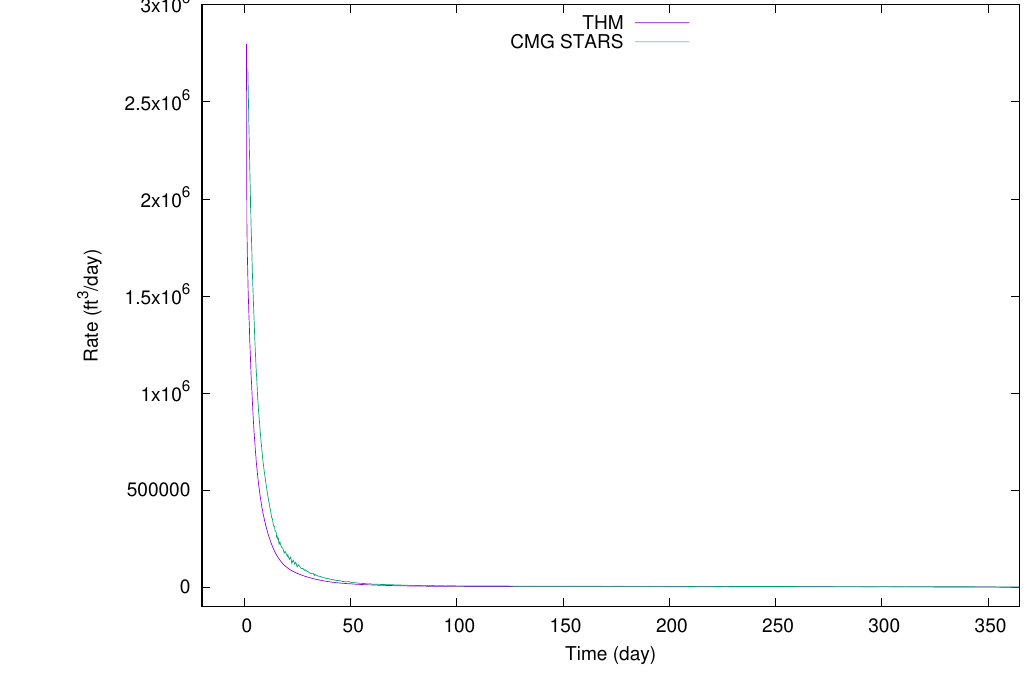
Figure 15. Example 2: total gas production rate (ft 3 /day).